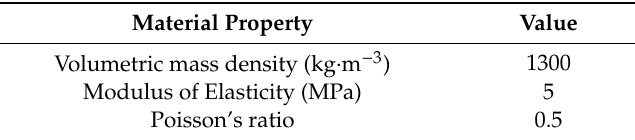
Table A5. Material properties used in the calculation of γ FvK and G i numbers for the compliant plant thin shells